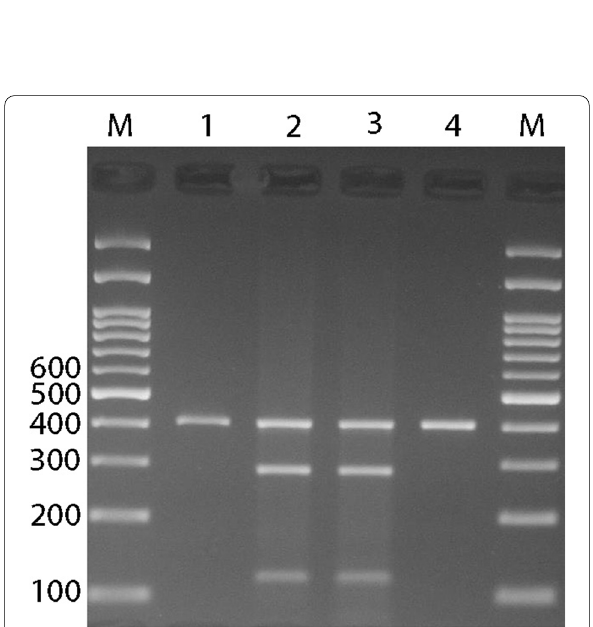
Fig. 3 Electrophoresis pattern of the PCR-RFLP products for AGTR1 rs5186 polymorphism detection. M: DNA marker; Lanes 1, 4: AA; Lanes 2, 3: AC